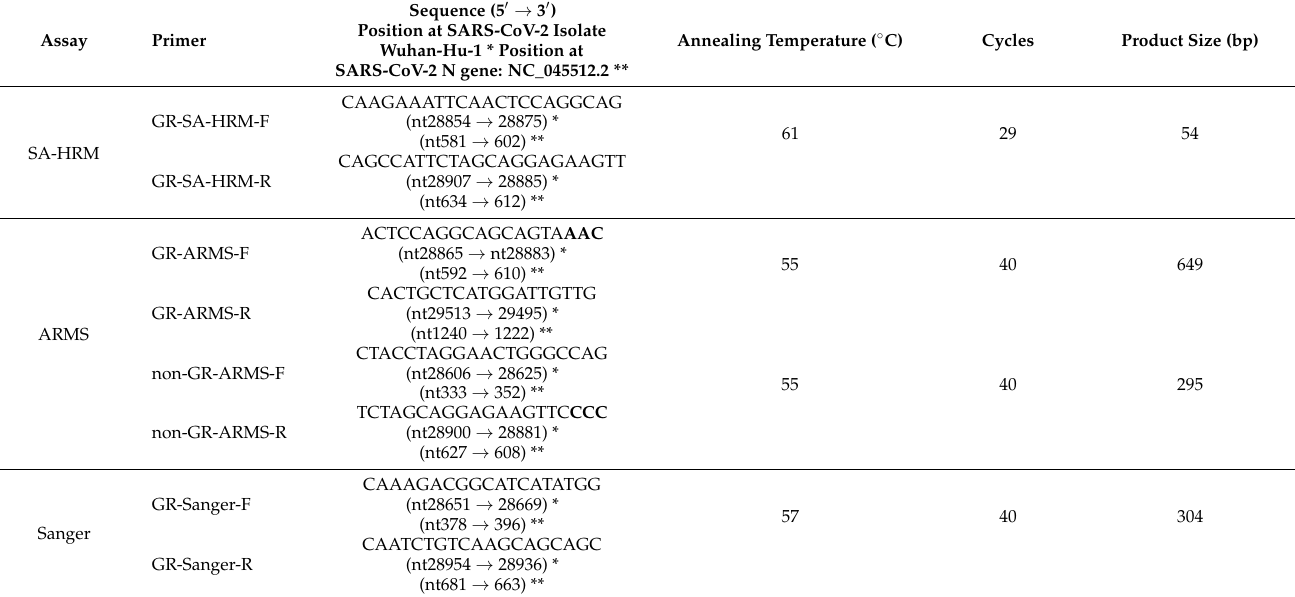
Table 1. Specifications of primers and PCR assays employed for the short-amplicon high-resolution melting analysis (SA-HRM), amplification-refractory mutation system (ARMS) and Sanger experiments. Bases in bold highlight the clade discrimination segments of the ARMS